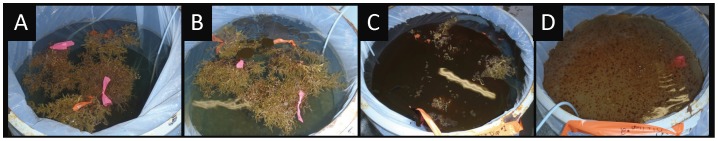
Evolution of experimental treatments.Example of mesocosms (A) prior to addition of oil, (B) following addition of 100 ml of Louisiana sweet crude oil, (C) five minutes after application of Corexit 9500 A dispersant, and (D) 12 hours after dispersant application.